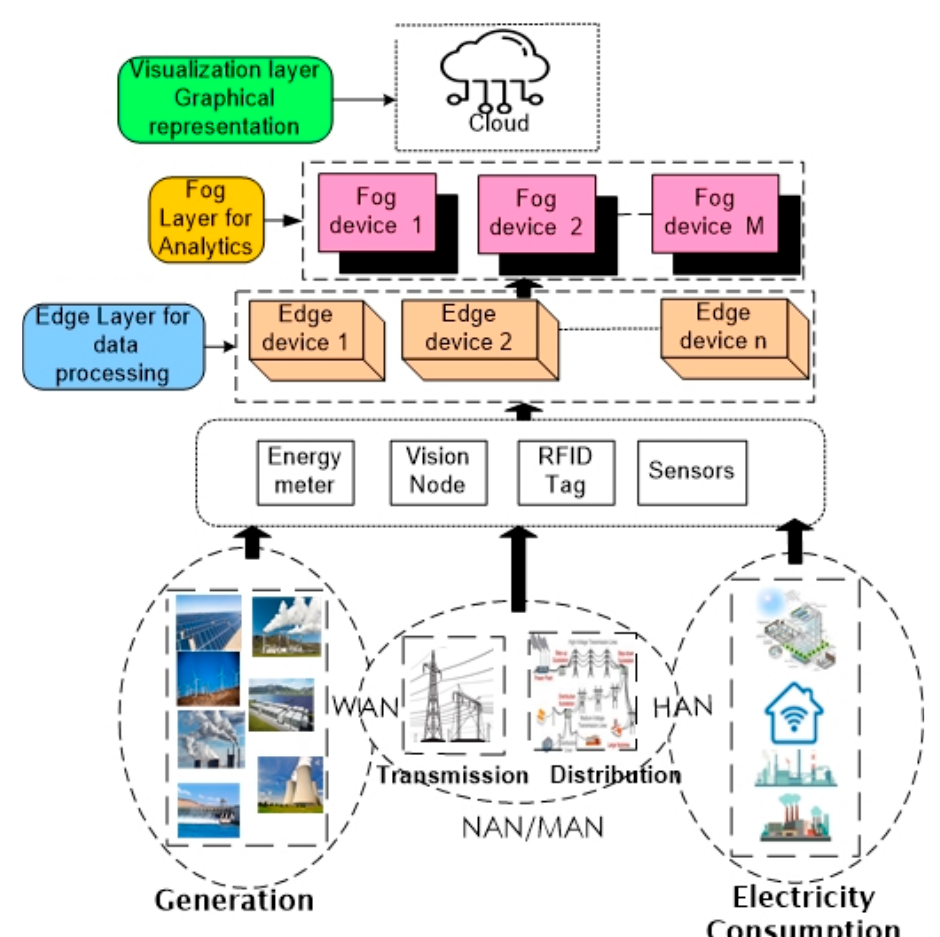
Figure 8. Hybrid fog-assisted cloud architecture for smart grid [131].